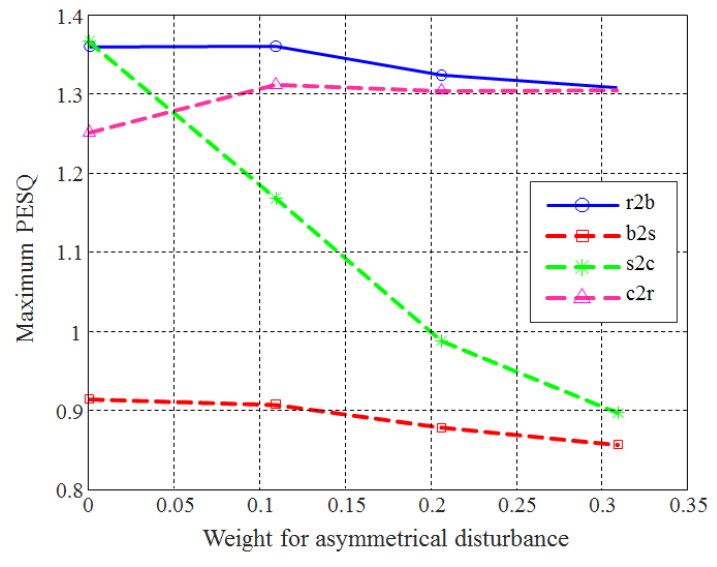
Figure 5. Average PESQs for each conversion pair according to the weight for the asymmetrical